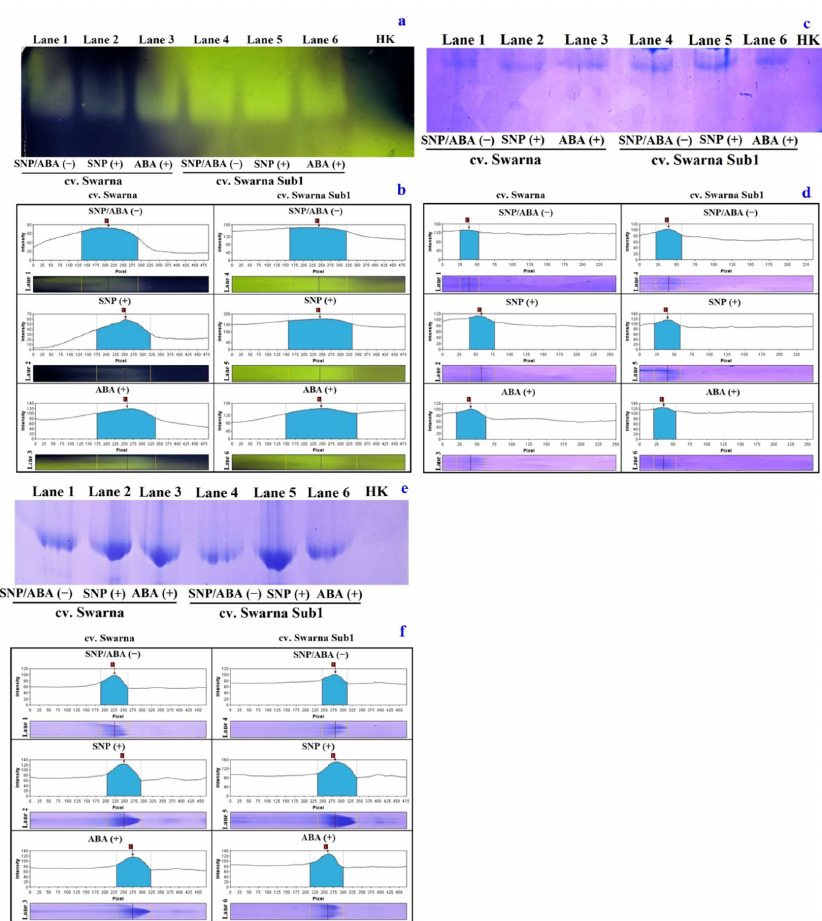
Figure 6. Polymorphic expression profile and densitometric analysis of NADP-ME activity (( a , b ), respectively), wall-bound invertase activity (( c , d ), respectively), cytosolic invertase activity (( e , f ), respectively) in two rice genotypes (cv. Swarna and Swarna Sub1) under salinity stress [SS (+)] and non-salinity stress [SS (−)] for 72 h with [SNP (+) or ABA (+)] or without [SNP/ABA (−)] priming for 24 h. Loading plot: HK- heat killed.